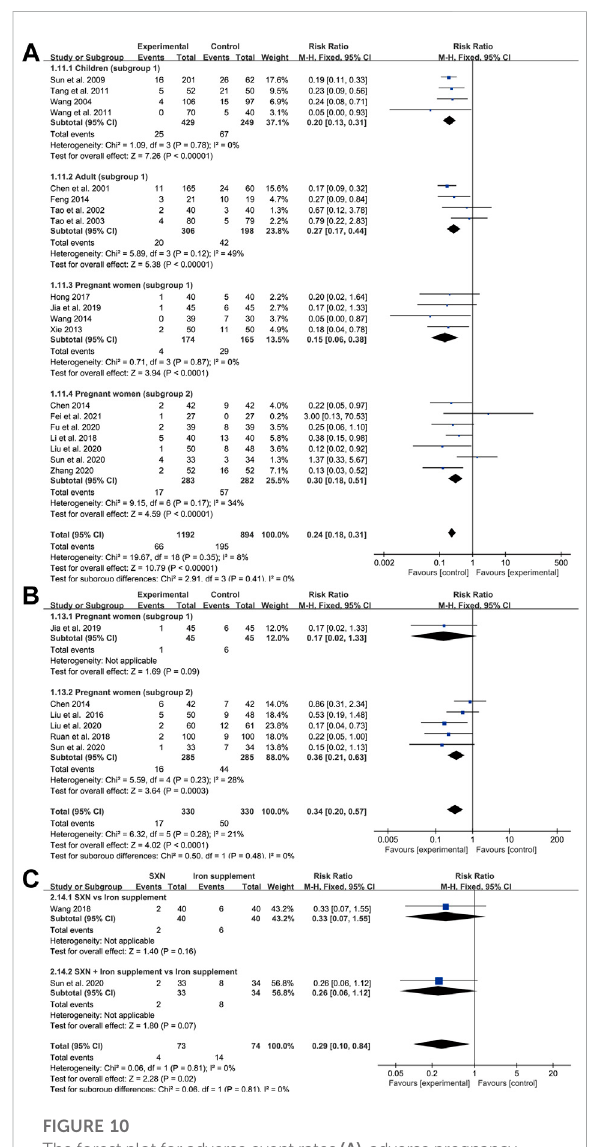
FIGURE 10 The forest plot for adverse event rates (A) , adversepregnancy outcomes (B) and anemia recurrence rates after the treatment till delivery (C) in pregnant women with